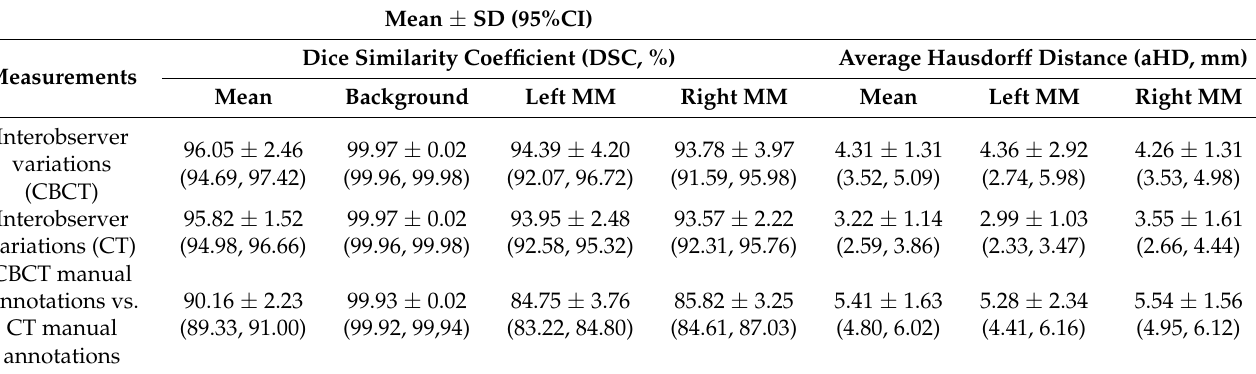
Table 1. The interobserver variations and manual annotation difference between CBCT and CT by Dice similarity coefficient (DSC, %) and average Hausdorff distance (aHD, mm) among 15 cases. Mean ± SD